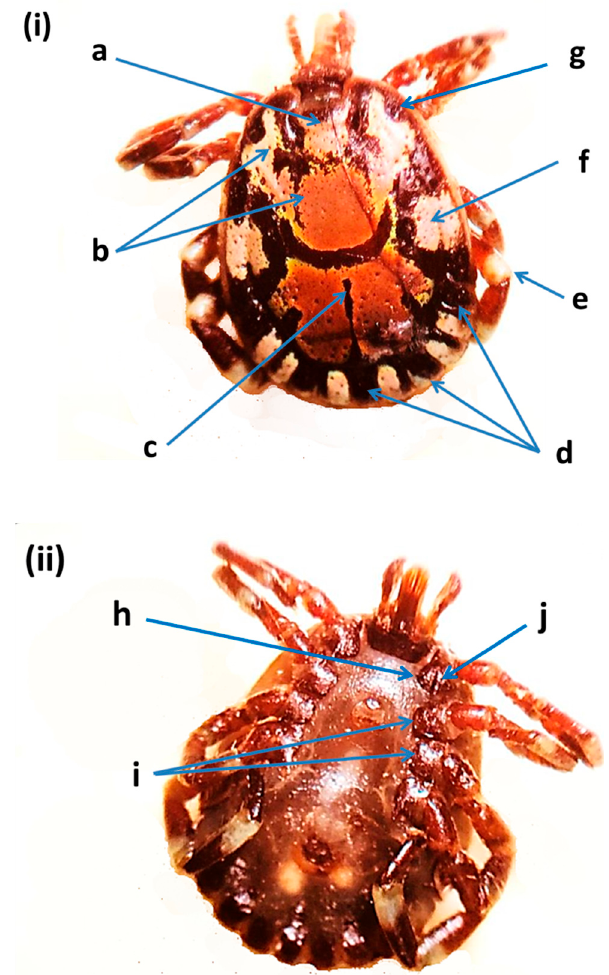
Figure 4. Amblyomma lepidum male from the United Arab Emirates: ( i ) dorsal view: (a) primary punctuation, (b) enamel color, (c) posteromedian strip, (d) festoon enameling, (e) leg with pale ring, (f) lateral median areas of enamel orientation, (g) eyes (distinctly convex); ( ii ) ventral view: (h) coxae I internal spur length, (i) coxae II and III, (j) coxae I external spur length [11,30].